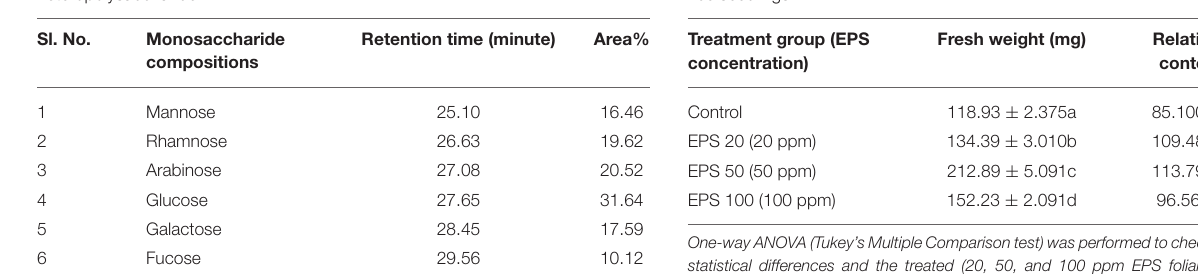
TABLE 7 | Fresh weight and relative water contents of exopolysaccharide sprayed rice